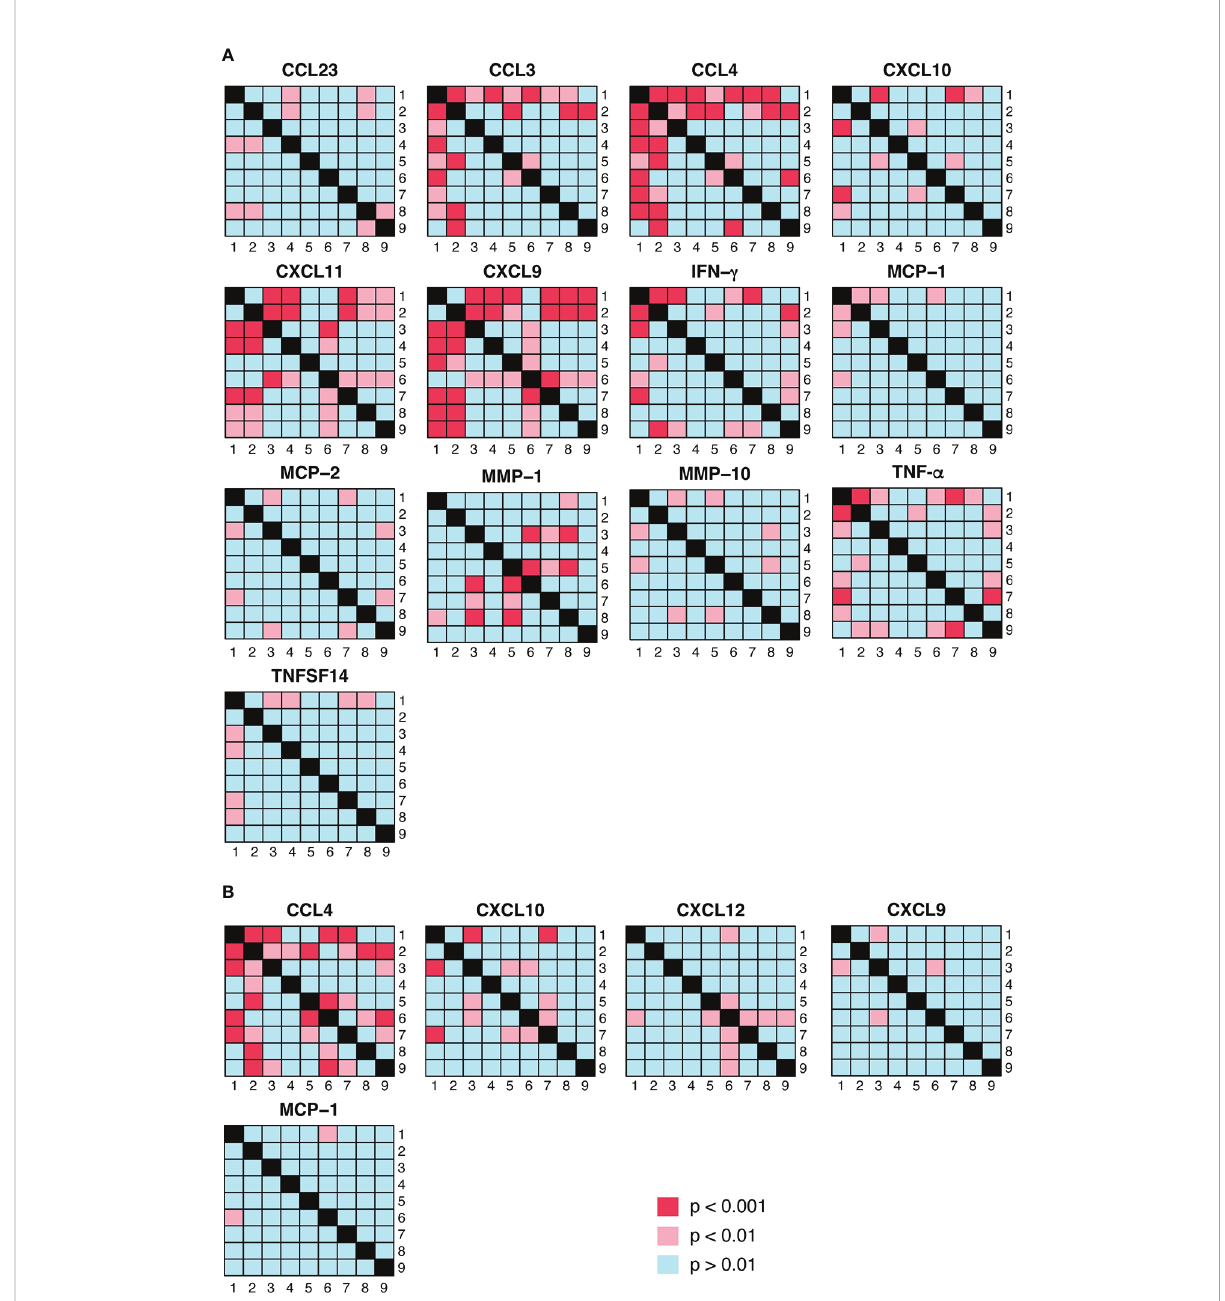
FIGURE 5 Visualization of pairwise statistical comparisons of protein abundance between PrEP arms. (A) shows the results of statistical comparisons between the different PrEP arms using Olink data whereas the Luminex results are presented in (B) . p < 0.01 was considered as signi fi cant in the comparisons between PrEP